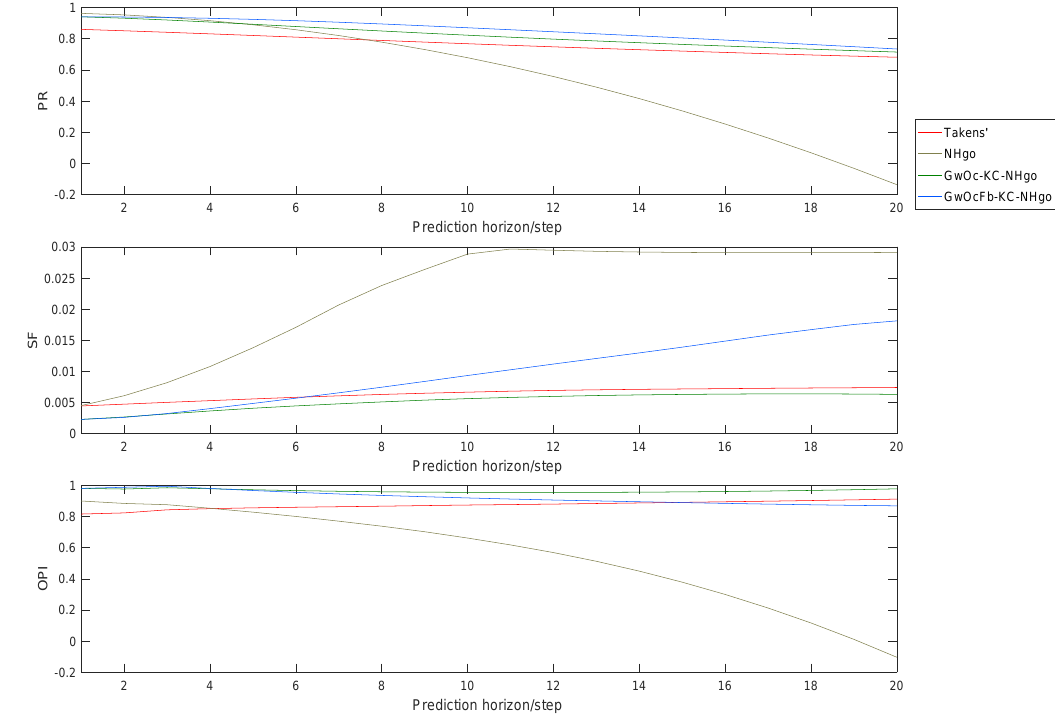
Figure 15. The comparison between Takens’, NHgo, GwOc-KC-NHgo and GwOcFb-KC-NHgo methods (left hip joint data in the sagittal